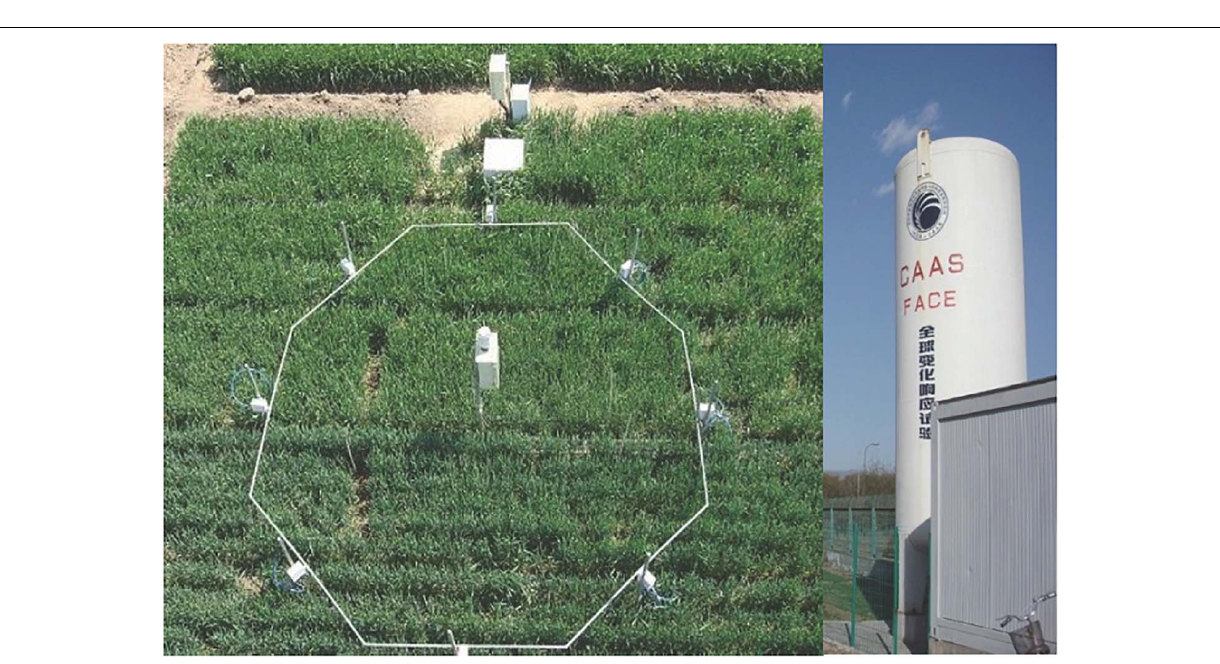
Frontiers in Plant Science |